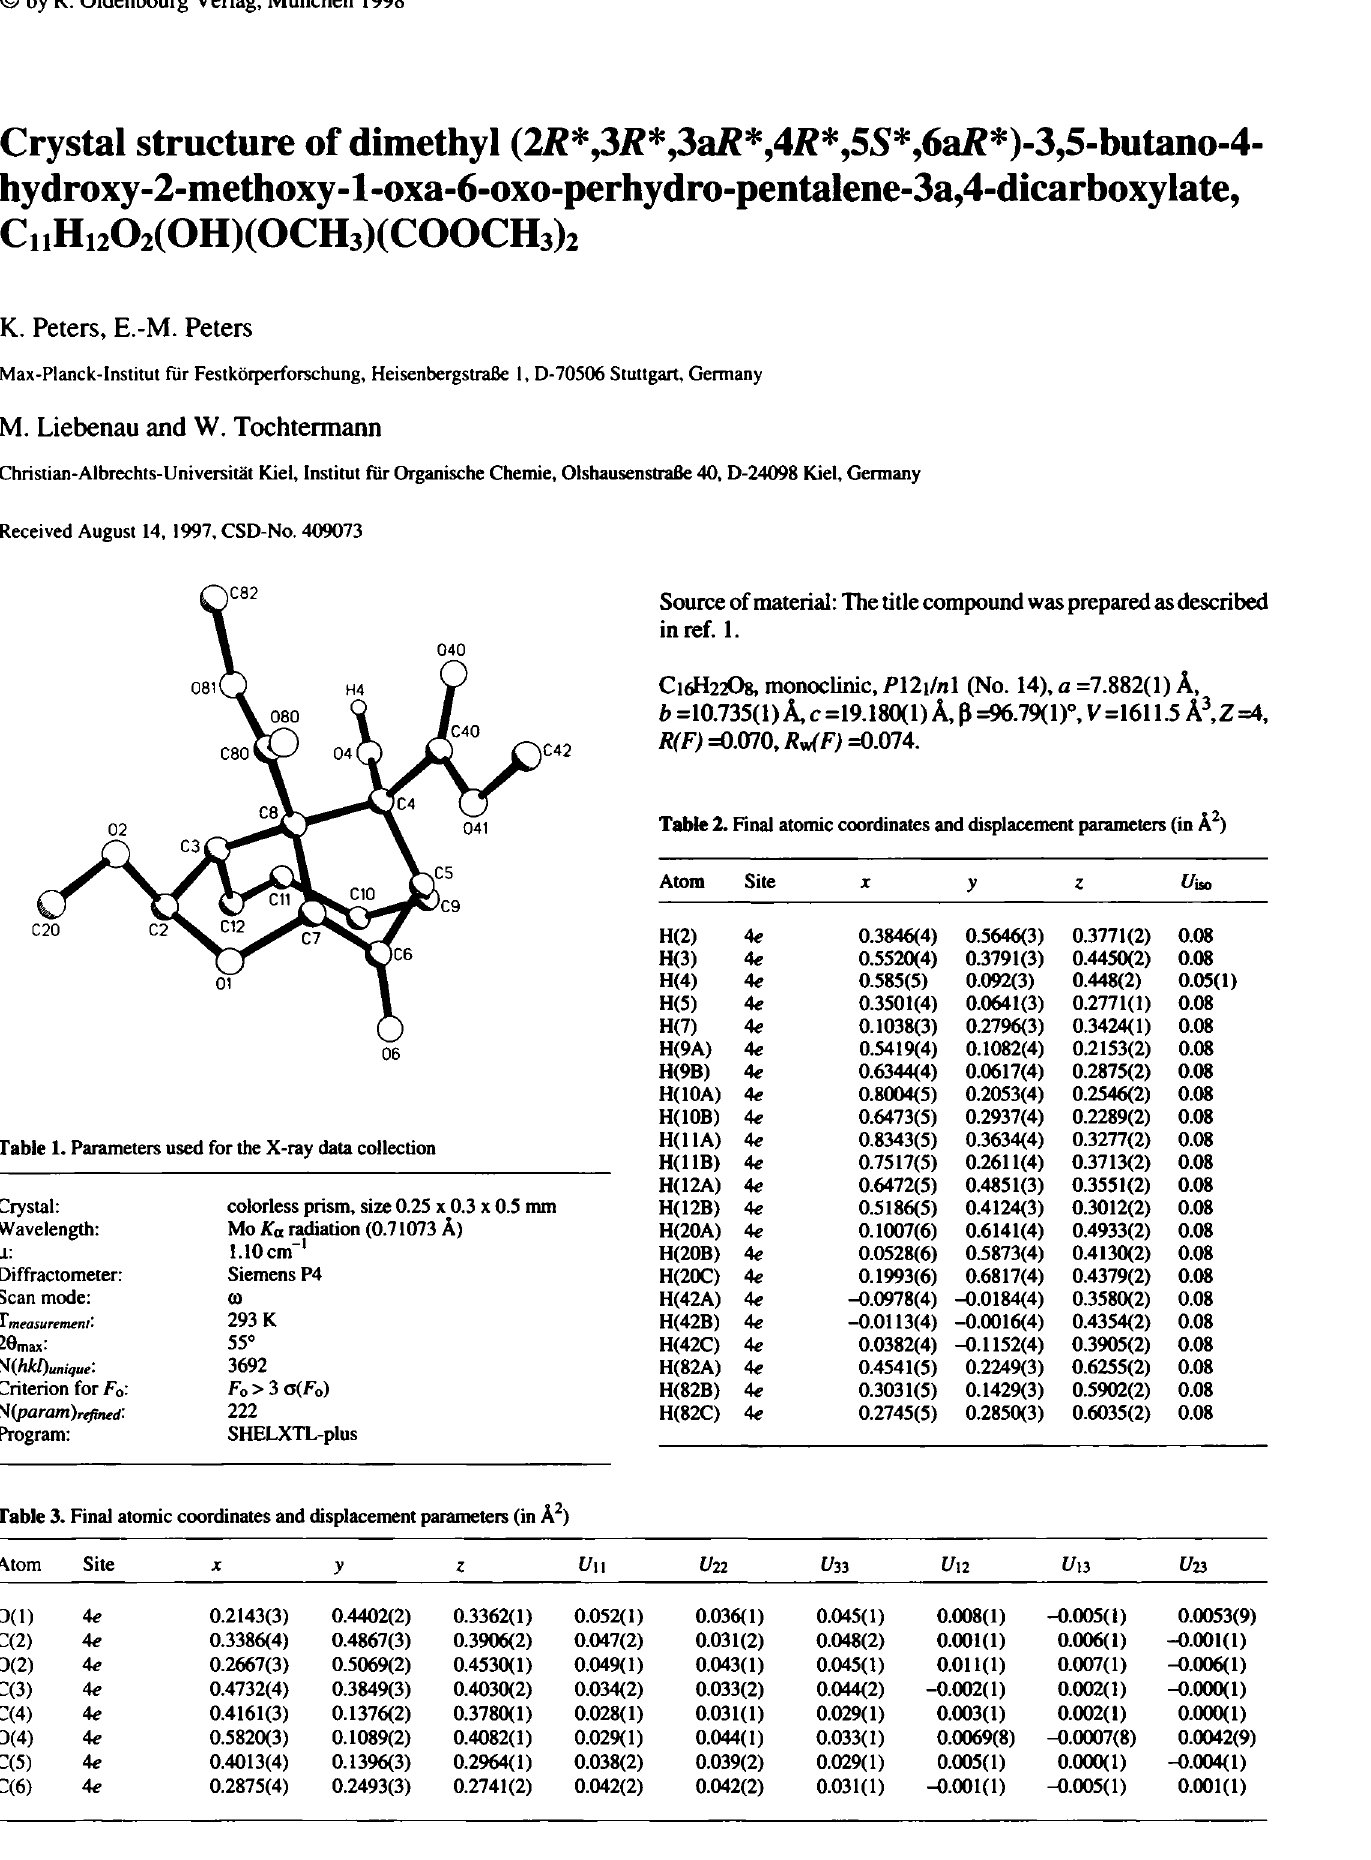
Table 3. Final atomic coordinates and displacement parameters (in Â^) Atom